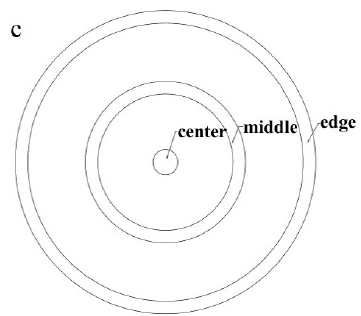
Figure 1. ( a ) The drawing of the compression–torsion specimen; ( b ) the pre-compression and torsional specimen; ( c ) the observation position of the specimen.